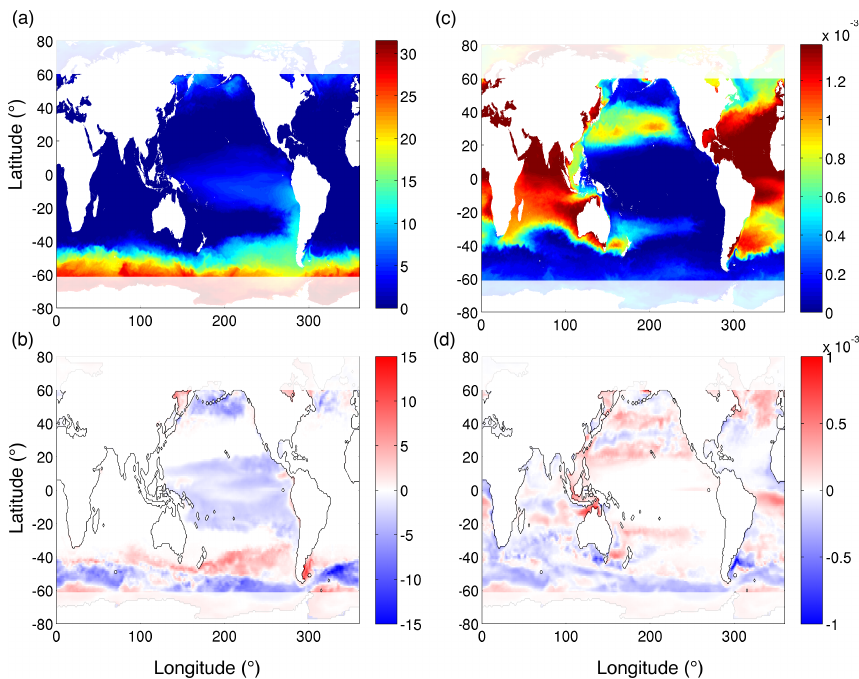
Figure 4. Annual average surface concentrations of (a) nitrate in mmolNm − 3 and (c) dissolved iron in mmolFem − 3 in the HR model solution for model year 1999; (b) the difference in nitrate and (d) the difference in dissolved iron. Positive values indicate higher values in the HR simulation, and negative values indicate higher values in the CR